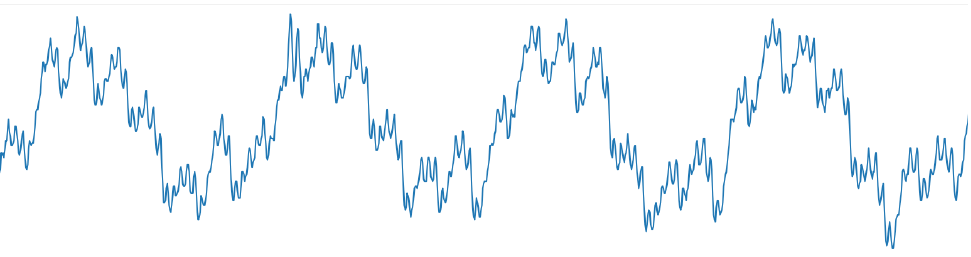
Figure 6: Oscilloscope power measurement during encryption with hardware AES